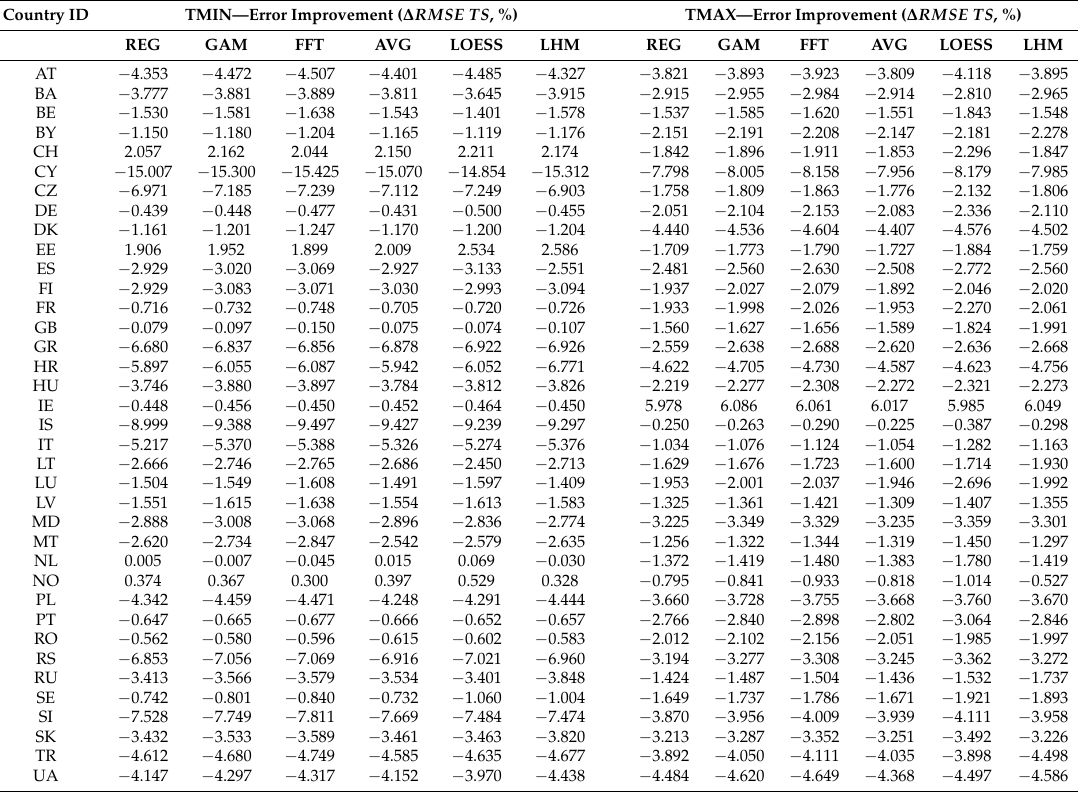
Table 2. Out-of-sample (TS) error improvements ( ∆ RMSE , %) obtained by including linear trends in all the methods, for the minimum and maximum temperatures from the 37 European countries. Country